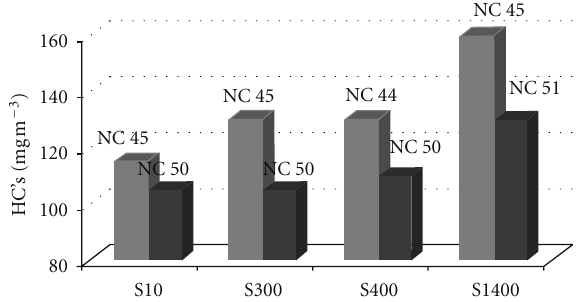
Figure 5: Correlation between HC’s and CN and a diesel cycle engine with mechanical